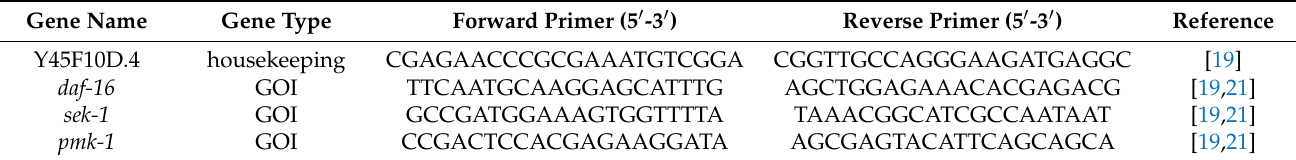
Table 2. Targeted C. elegans genes primers for qPCR